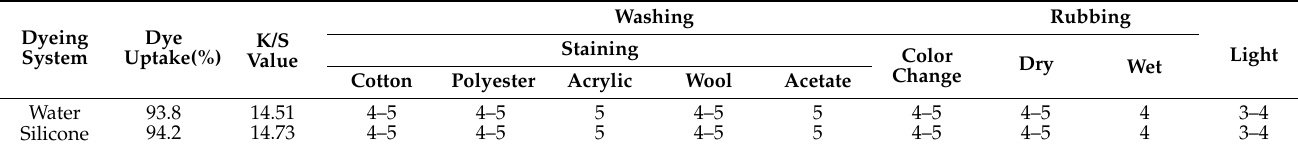
Table 1. Dyeing performance of polyester fabrics dyed in silicone waterless dyeing system.